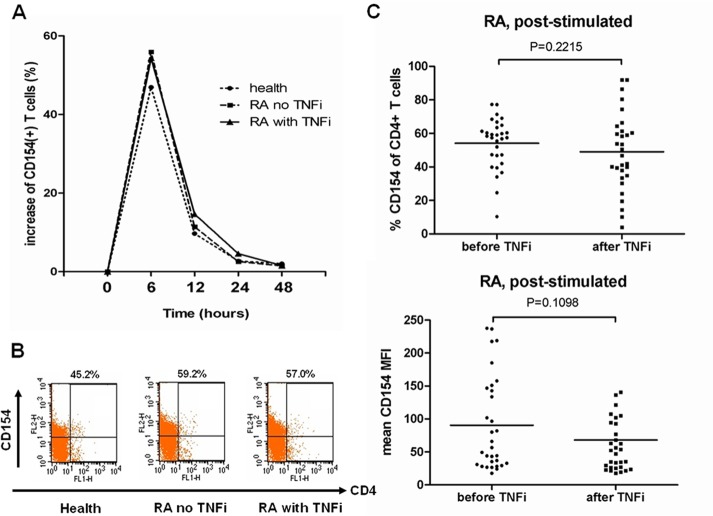
The post-stimulated CD154 expression levels in RA patients between baseline and after TNF-α blockade treatment.(A) and (B) CD4+ T cells were purified from health control (n = 7) and RA patients with (n = 8) and without (n = 9) TNF-α blockade treatment. After stimulation with ionomycin (1 μg/mL) and PMA (50 ng/mL) for different time periods, the CD154 expression levels (% CD154 of CD4+ T cells) were measured by flow cytometry. Data were presented as mean increase of CD154 percentage of CD4+ T cells. (C) CD4+ T cells were purified from RA patients (n = 30) before and after TNF-α blockade treatment for 3 months. After stimulation with ionomycin (1 μg/mL) and PMA (50 ng/mL) for 6 hours, the CD154 expression levels (CD154 percentage and MFI of CD4+ T cells) were measured by flow cytometry. Data were presented as mean percentage and MFI. TNFi: TNF-α inhibitor; MFI: mean fluorescence intensity.